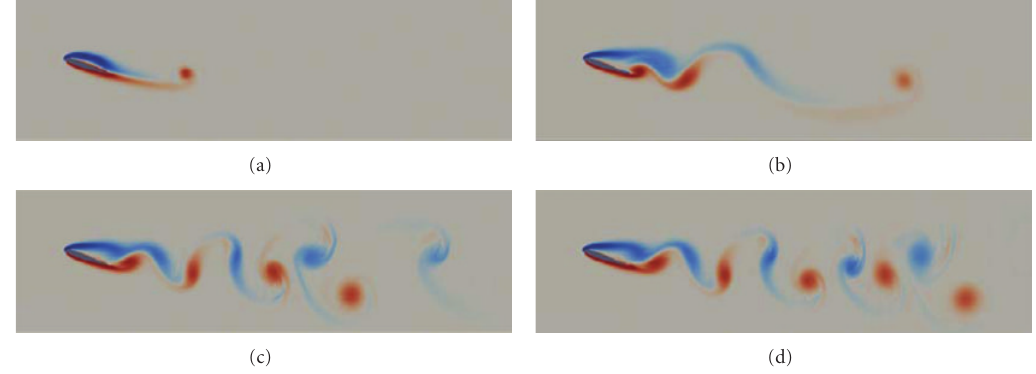
Figure 19: Vorticity plots of Re = 400 when M = 2 for t = 1 . 9 (a), 6.3 (b), 10.7 (c), and 12.9